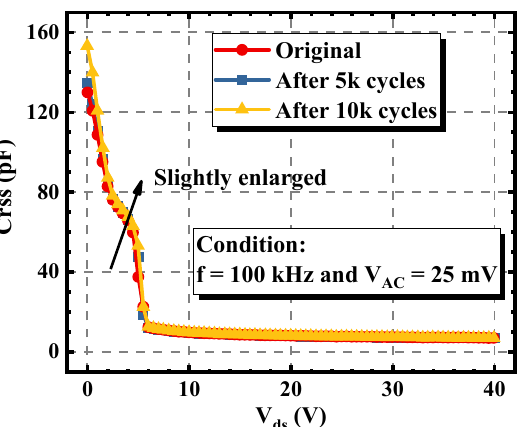
Figure 6. Variations of the C gd of the asymmetric trench SiC MOSFET under different avalanche stress cycles.